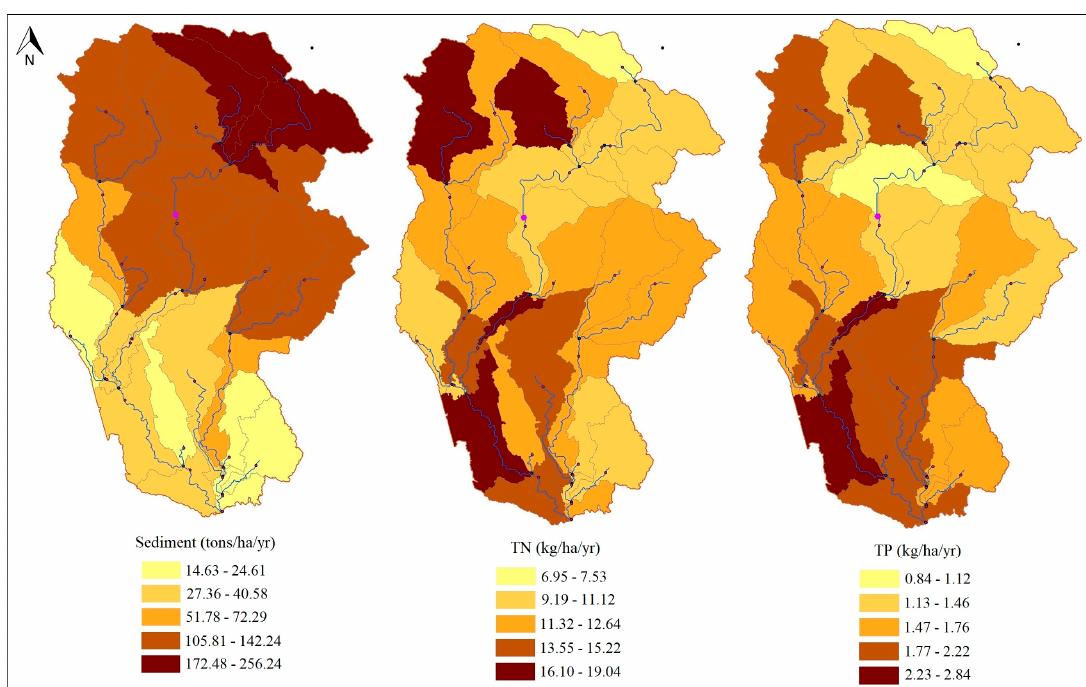
Figure 10. The Critical Source Areas (CSAs) in the basin, identified using individual indices.